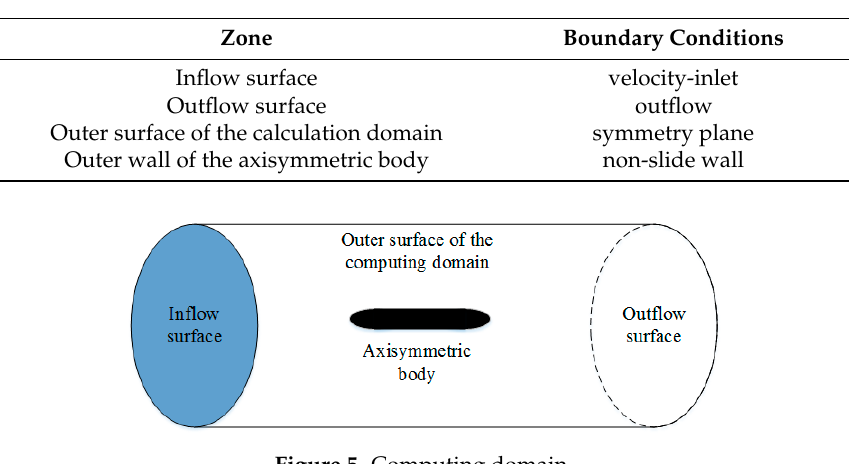
Table 1. Boundary conditions of numerical calculation.